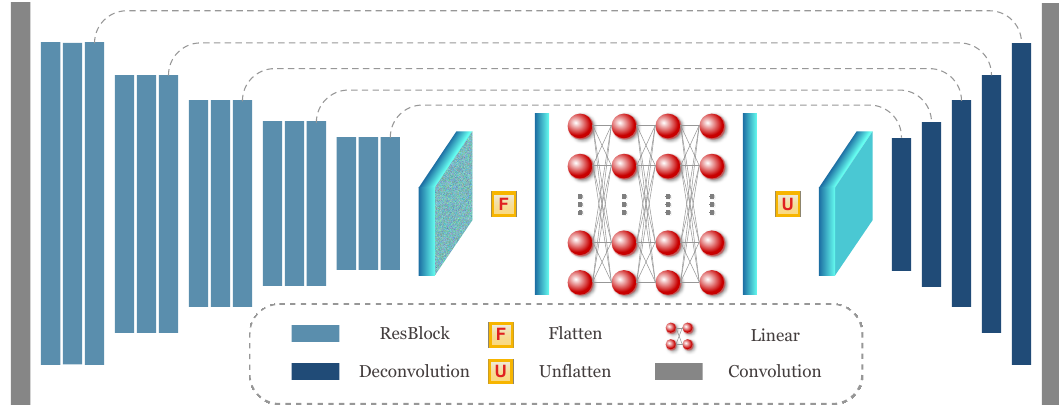
Figure 3. The network structure of weight generation network. The U-Net structure is an encoder-decoder network. The encoder and decoder parts consist of fully convolutional networks. Fully connected layers are applied to the flattened encoded features to provide spatial position information. See the text for more